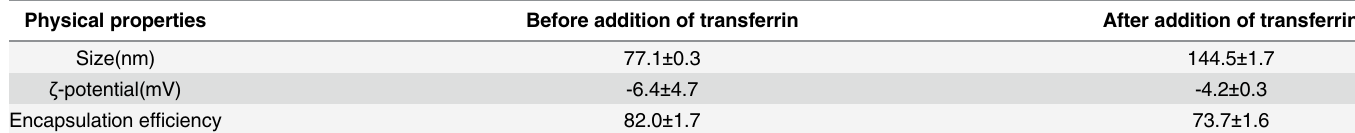
Table 1. Size, ζ -potential and Encapsulation efficiency of LPs before and after coupling of Tf at pH 7.4. Data are shown as means and standard devia- tion (n =